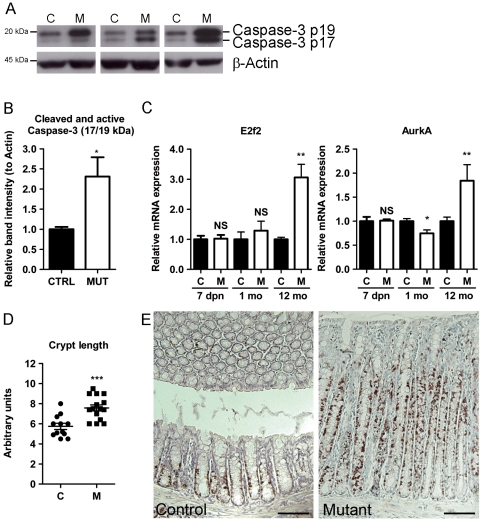
The apoptotic pathway is overly active and the proliferative dynamic is altered in regenerative epithelium.(A) Increased abundance of cleaved and active forms of caspase-3 in 12 month-old mutants (Open bar) relative to controls (Black bar). (B) Quantification of band intensities of cleaved and active caspase-3 combined (n = 4) normalized to β-actin (Black bars, controls; open bars, mutants). Represented as means ± SEM, * P≤.05. (C) E2f2 and AurkA modulations seen in microarray data were verified at various time points in mutants (Open bars) relative to controls (Black bars). Expression levels are shown as mean values (± SEM) relative to controls for each time point (3–14 mice per group) and were normalized with the Tbp housekeeping gene. (D) Measurements (n = 4 per group) of crypt length. (E) Ki67 immunochemistry of 12 month-old control mice compared to a hyperplasic area seen in mutants of same age. * P≤.05, ** P≤.01 and *** P≤.001.